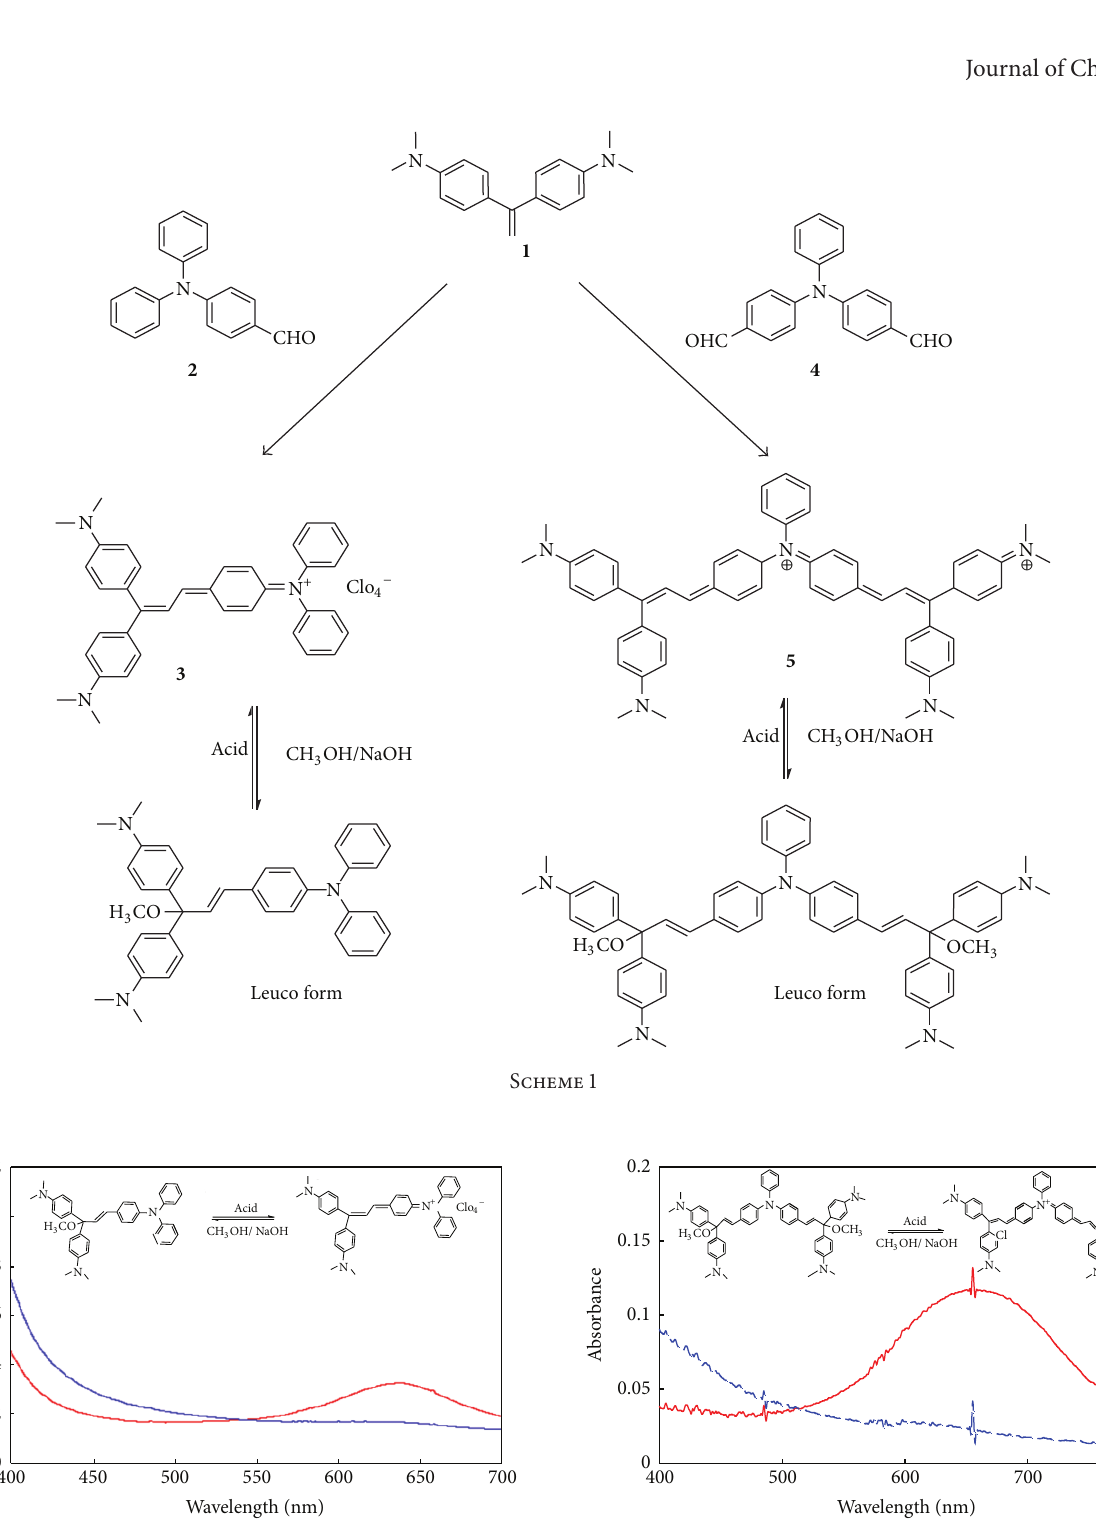
Figure 3: Absorption spectra of methane dye 3 and its leuco form in dichloromethane.